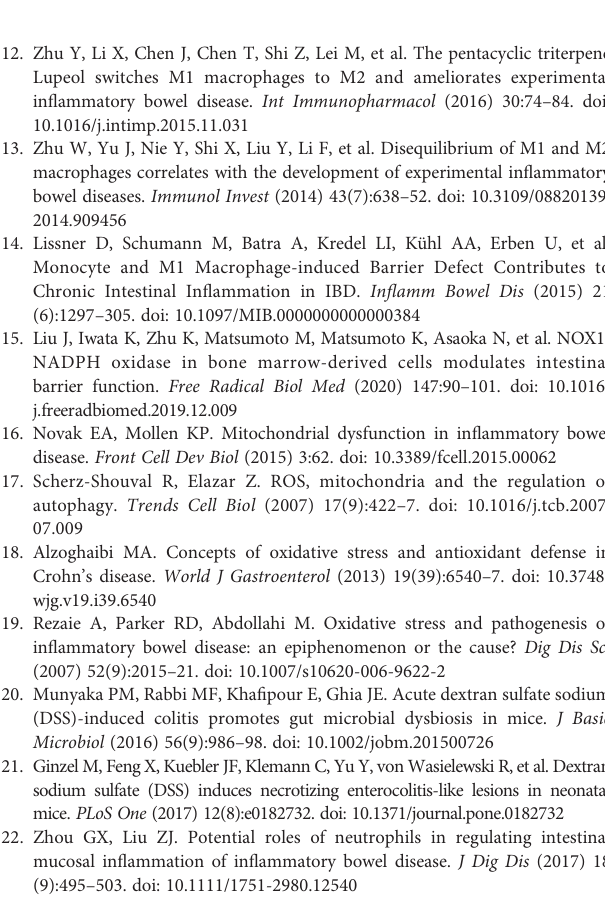
SUPPLEMENTARY FIGURE 4 | The analytical process of WGCNA. (A) Sample dendrogram and trait heatmap in GSE75214. (B) Identi fi cation of the optimal soft threshold. (C – E) Construction and visualization of co-expression modules. SUPPLEMENTARY FIGURE 5 | Identi fi cation of DEGs between UC-active samples and normal samples in GSE75214 cohort. The volcano plot shows the DEGs between UC-active samples and normal samples (log twofold change FC >1 and an adjusted P value <0.05). SUPPLEMENTARY FIGURE 6 | Identi fi cation of immune cell in fi ltration in GSE75214 cohort. (A) The composition of immune cells in the tumor microenvironment in GSE75214 cohort. (B) The radar chart showed the correction of PDE4B level, and the in fi ltration of 22 types of immune cells was determined by the CIBERSORT R package. SUPPLEMENTARY TABLE 1 | Sequences of primers used for RT-PCR. SUPPLEMENTARY TABLE 2 | Antibodies used in the western blot and FACS. SUPPLEMENTARY TABLE 3 | Identi fi cation of DEGs between UC-active samples and normal